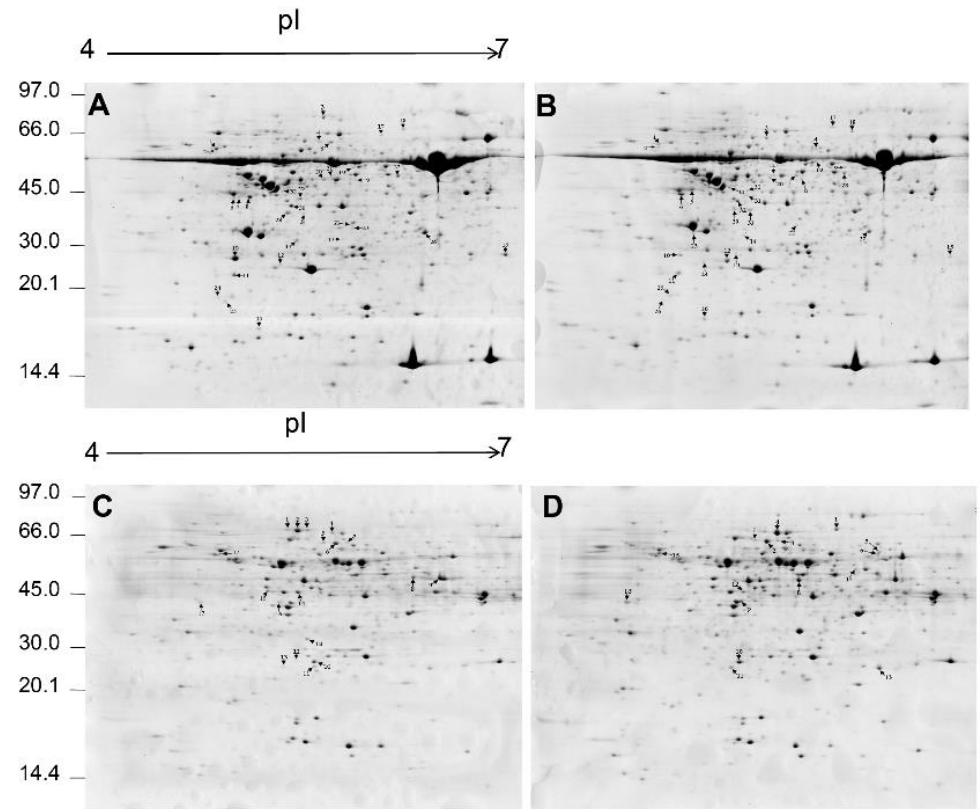
Figure 3. The 2-DE profiles of SD and XJ Eutrema proteins under normal hydroponic conditions for 6 weeks. The marked spots were identified by ESI-MS/MS. ( A ) 2-DE protein gel was from SD Eutrema shoots. ( B ) 2-DE protein gel was from XJ Eutrema shoots. ( C ) 2-DE protein gel extracted from SD Eutrema root. ( D ) 2-DE protein gel extracted from XJ Eutrema root.